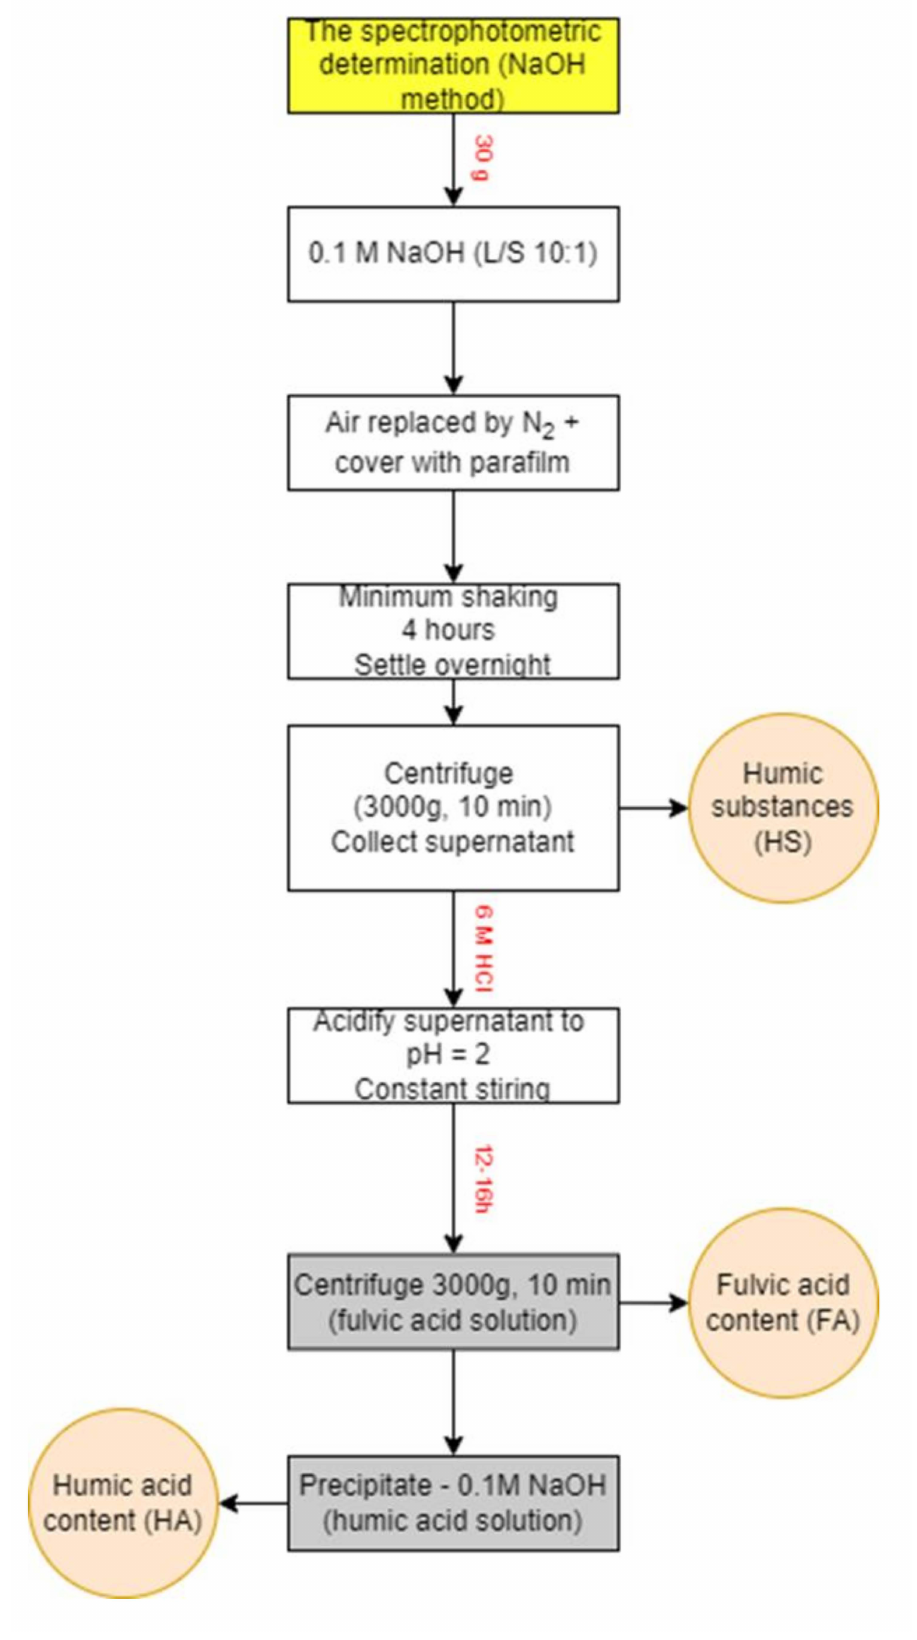
Figure 13. The scheme of spectrophotometric method (NaOH